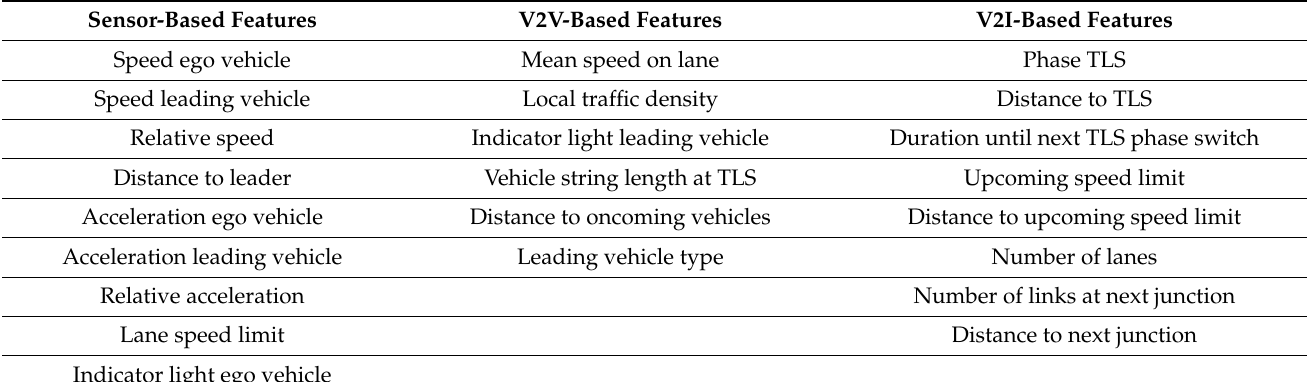
Table 2. Overview of the complete feature set for the prediction